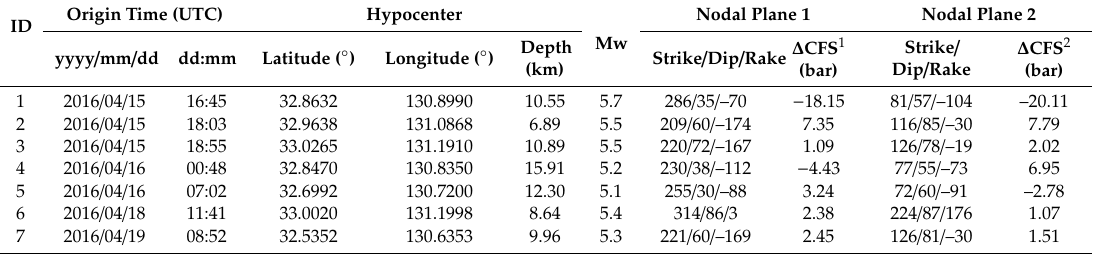
Table 3. Coulomb stress changes at the hypocenter resolved on the two conjugate nodal planes of the focal mechanisms of aftershocks with Mw >